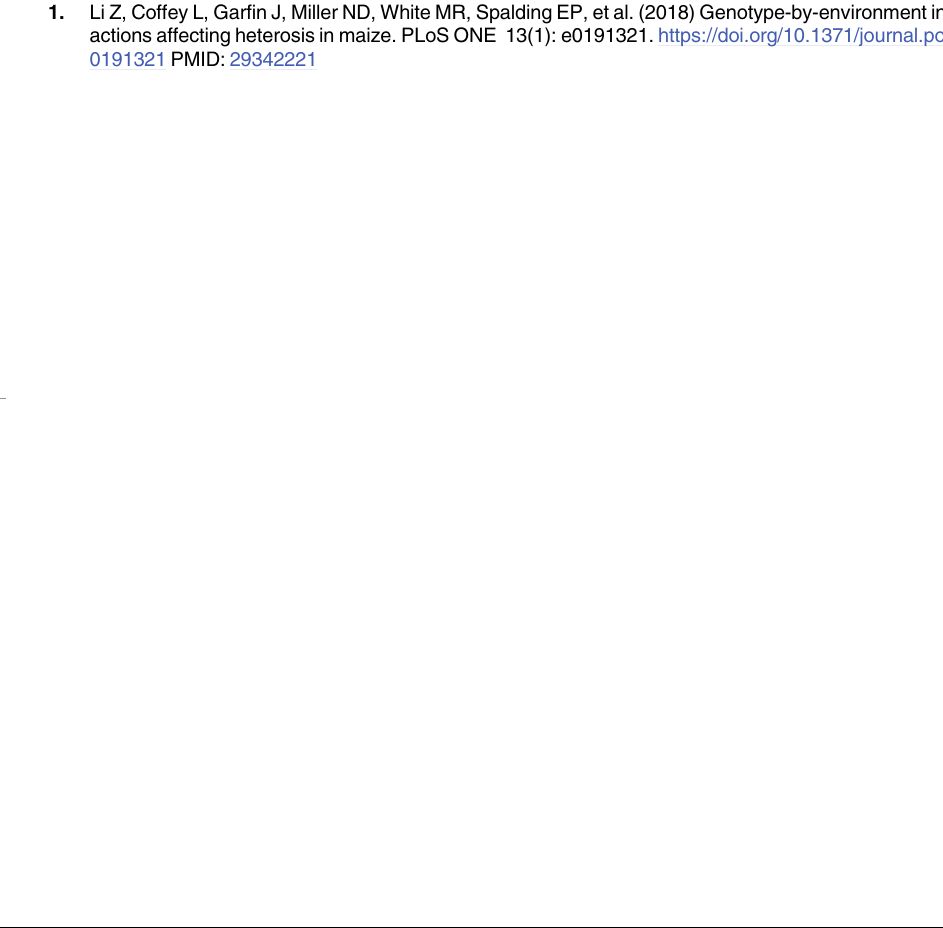
S3 Table. Raw phenotypic data for 25 traits measured on 11 inbreds and 47 hybrids at 16